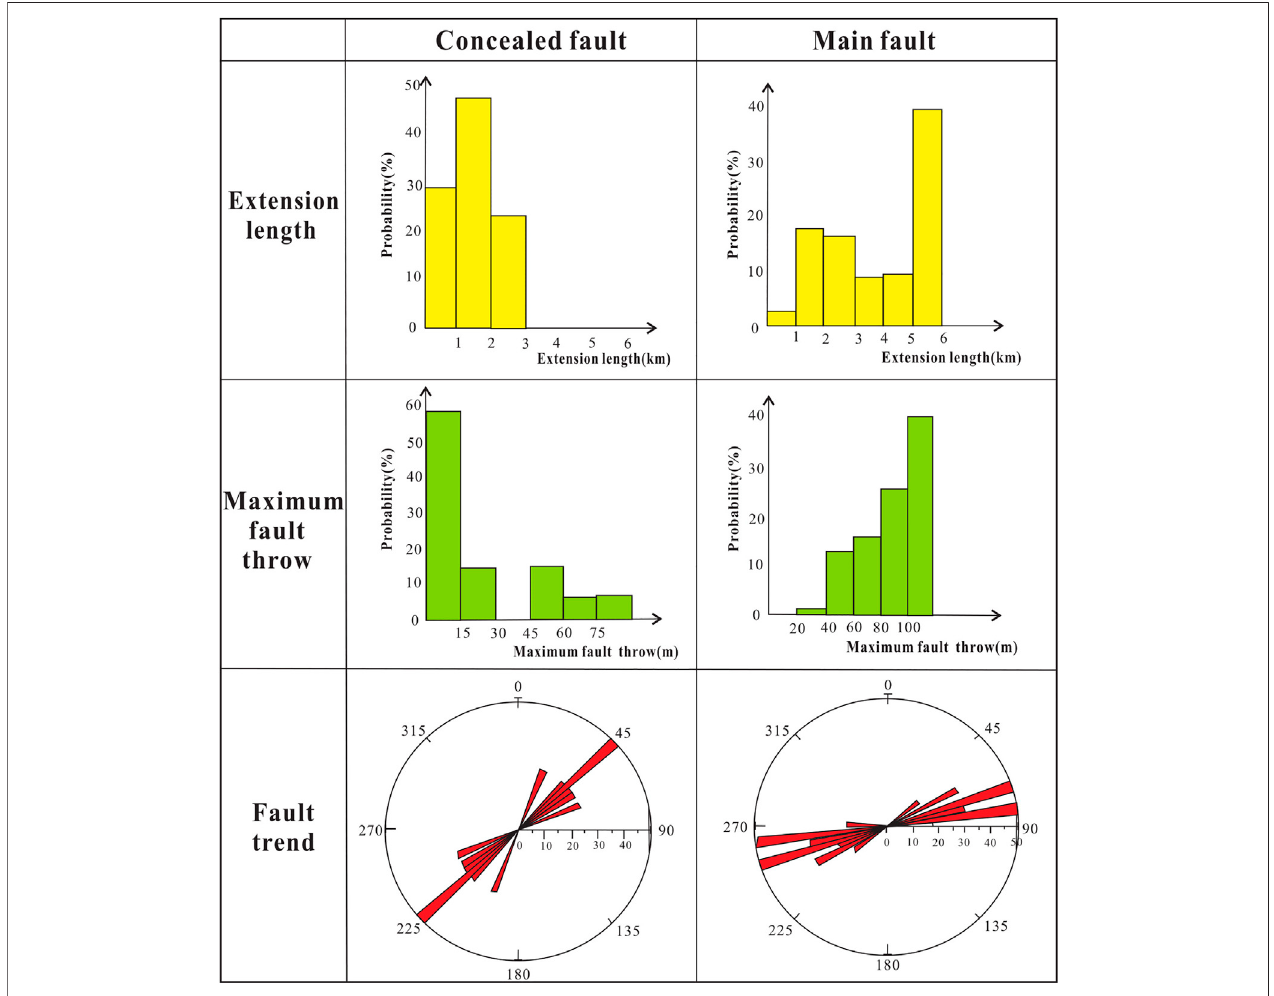
FIGURE 6 | Summary of fault extension length, maximum fault distance, and fault strike of concealed and main faults in the Huawa area.